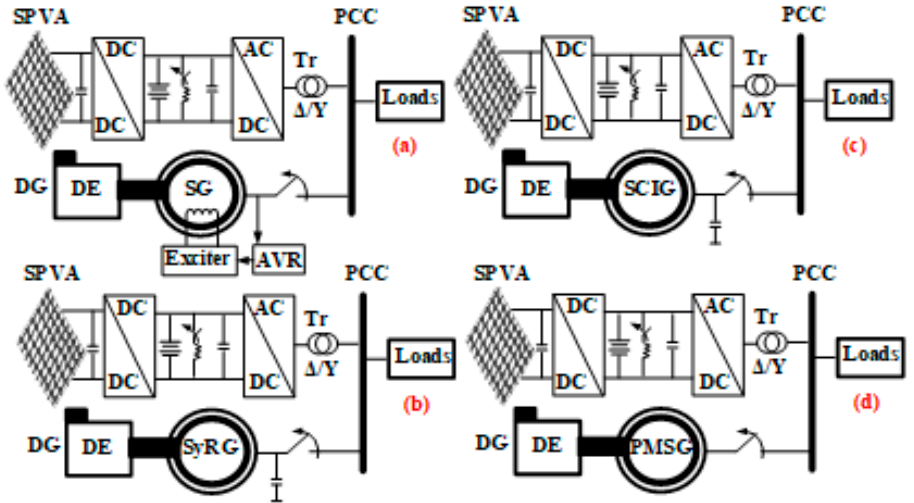
Figure 1. Off-grid configurations having SPVA and DE driven; ( a ) SG, ( b ) SyRG, ( c ) SCIG, and ( d ) PMSG.